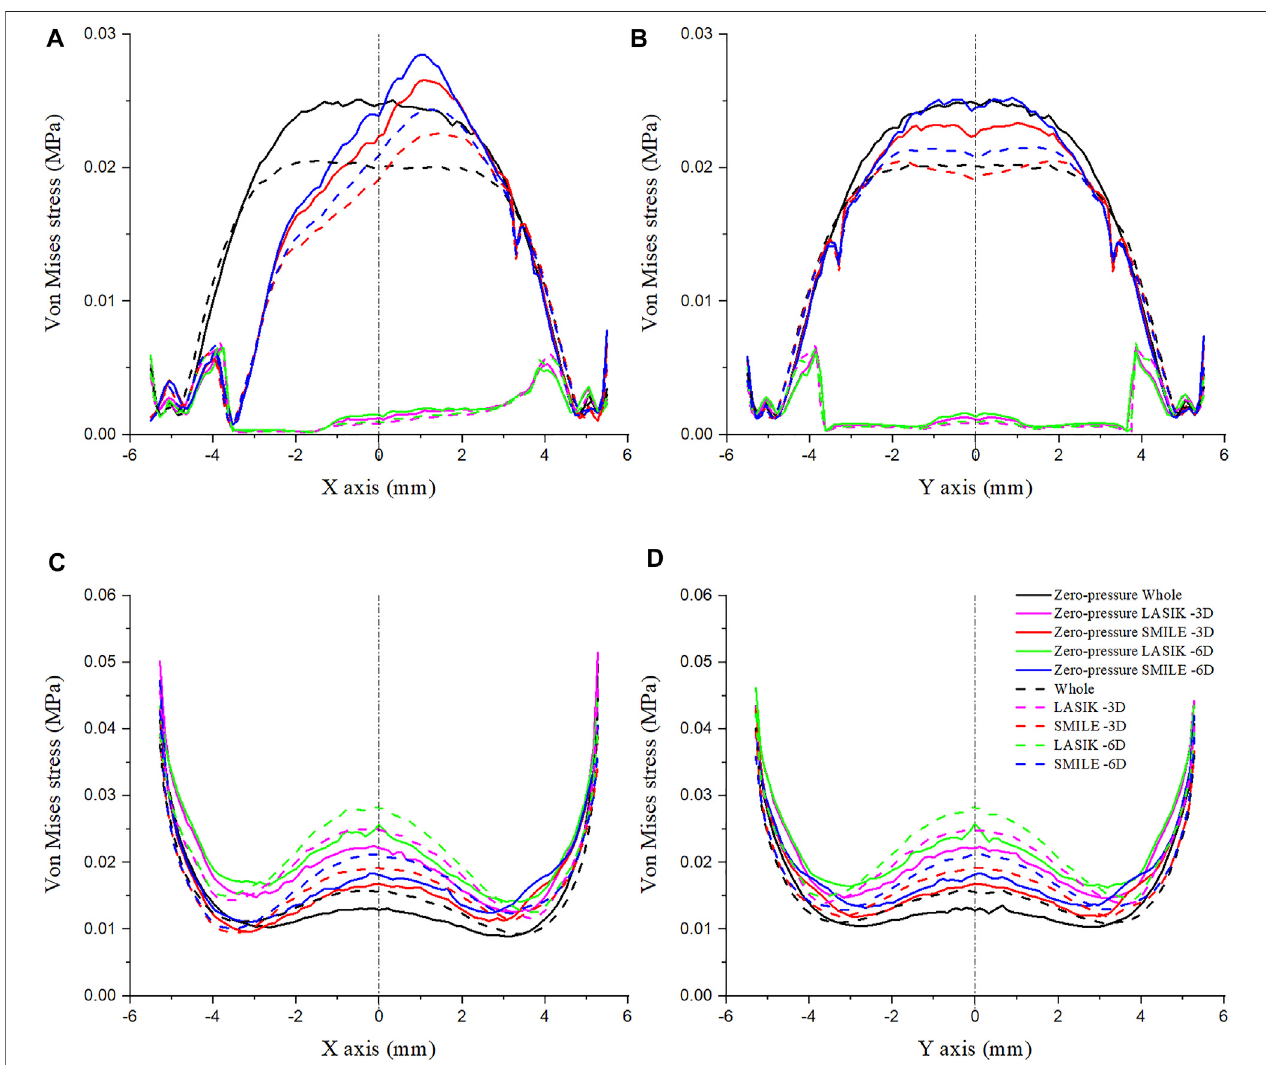
FIGURE 6 | Comparison of Von Mises stress on the cornea along the different paths. The IOP was constant at 19 mmHg. (A) Von Mises stress on the anterior corneal surface along the x -axis. (B) Von Mises stress on the anterior corneal surface along the y -axis. (C) Von Mises stress on the posterior corneal surface along the x -axis. (D) Von Mises stress on the posterior corneal surface along the y